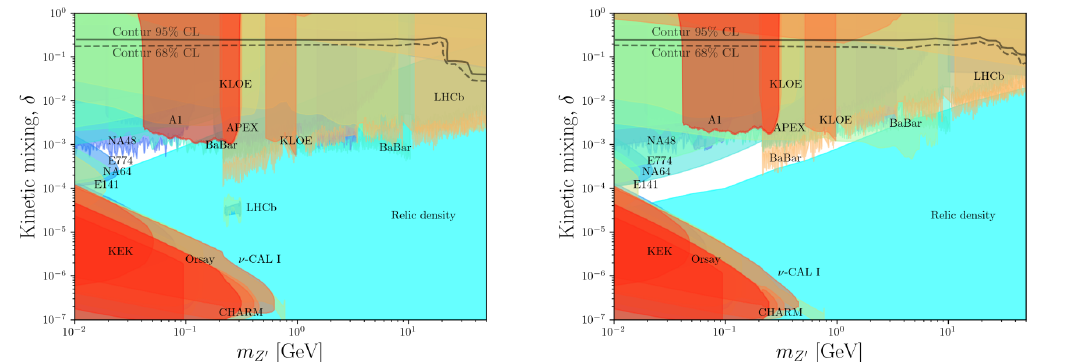
Figure 6 . Constraints from various visible and invisible limits for a Stueckelberg dark photon in the mass range less than the Z boson mass. The left panel corresponds to g X = 0 . 1 and the right for g X = 1 . 0 and with the common assumption that m D = m Z 0 / 4 . The light blue region corresponds to the relic density